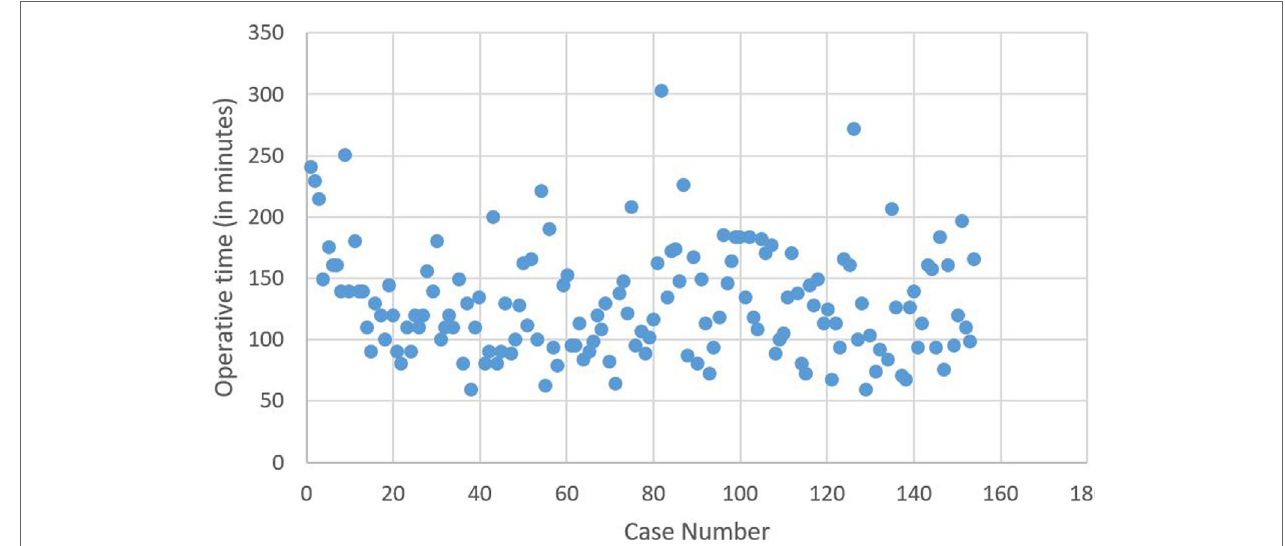
FigUre 1 | Operative time (in minutes) depending on case number, independent of the surgeon